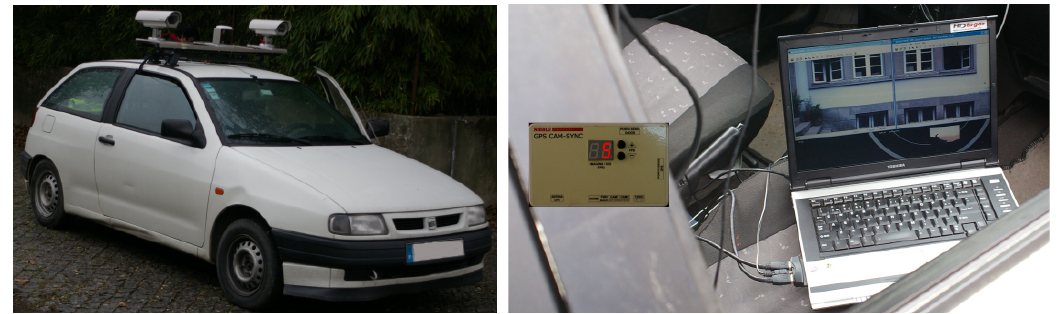
Figure 11. System components during survey.